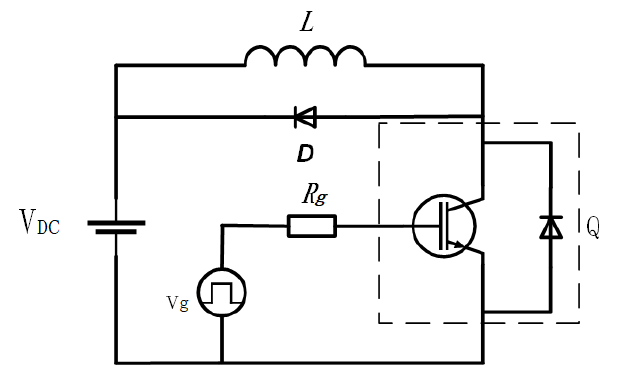
Figure 1. IGBT typical application